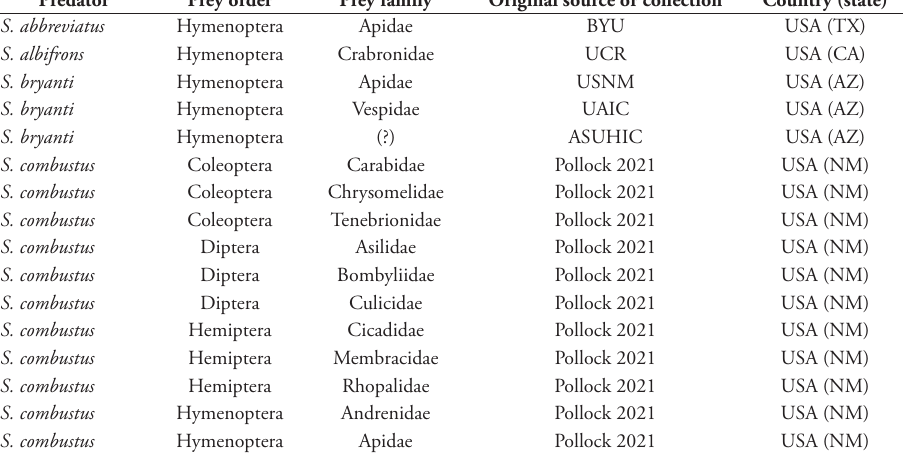
Table 1. Adult Saropogon predation records in North America. Records gathered from Lavigne 2016 online database (specimens were not examined personally); Arizona State University, Hasbrouck Insect Collection (ASUHIC); Bellamy 2002; Brigham Young University, Provo, Utah (BYU); University of California, Davis, The Bohart Museum of Entomology (BMEC); Bromley 1934; Hurd 1952; Hurd and Linsley 1975; New Mexico State University Arthropod collection (NMSU); Pollock 2021; Sweetman 1958; Texas A&M Univer- sity insect collection (TAMUIC); Thorp 1973; University of Arizona Insect Collection (UAIC); University of California, Riverside, Entomology Research Collection (UCR), and the Smithsonian’s National Museum of Natural History (USNM) pinned collection. Duplicate prey records for the same species are not